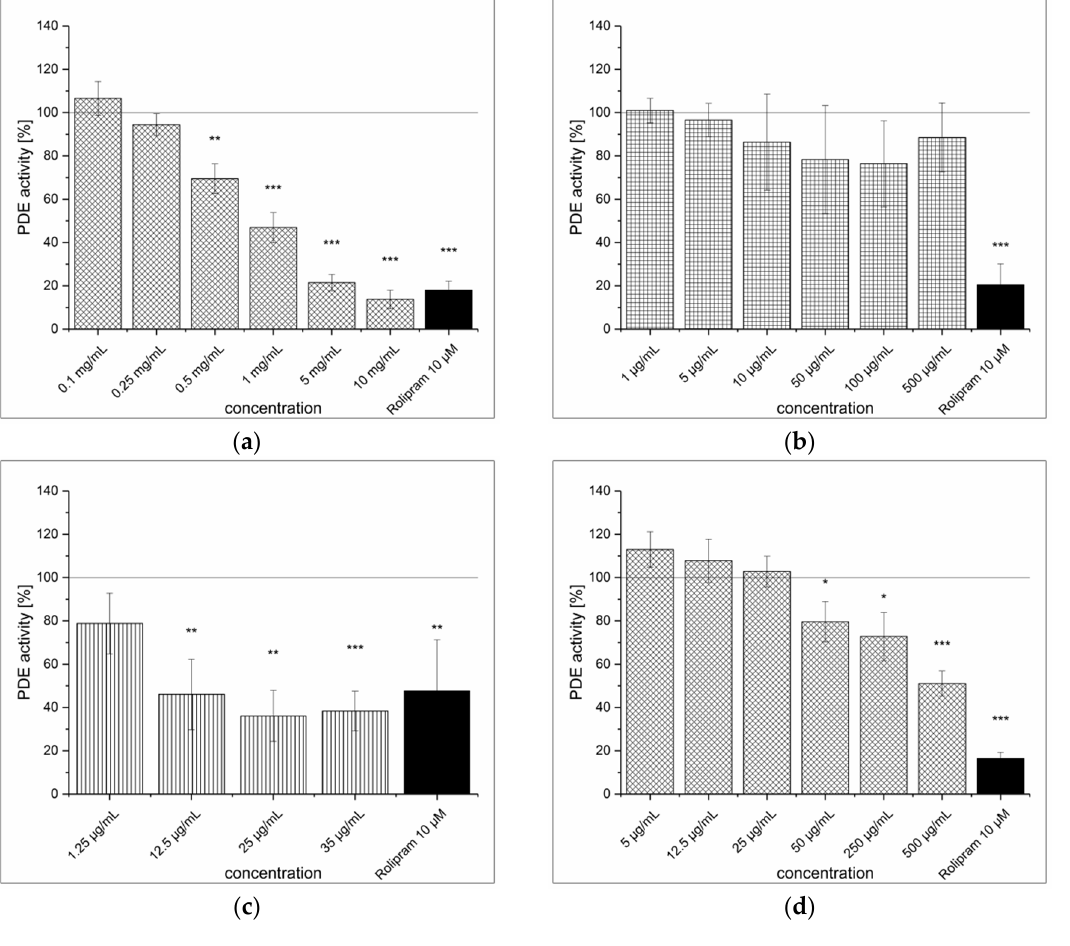
Figure 4. cAMP ‐ specific phosphodiesterase (PDE) activity following incubation with artichoke leaf extract (ALE) ( a ), luteolin ‐ 7 ‐ O ‐ glucuronide ( b ), luteolin ( c ) and 3,4 ‐ dicaffeoylquinic acid ( d ). Data are presented as the mean ± standard deviation of three independent experiments. The significance of differences between sample and control was assessed with a Student’s t ‐ test. Confidence intervals: * p < 0.05; ** p < 0.01; *** p < 0.001.